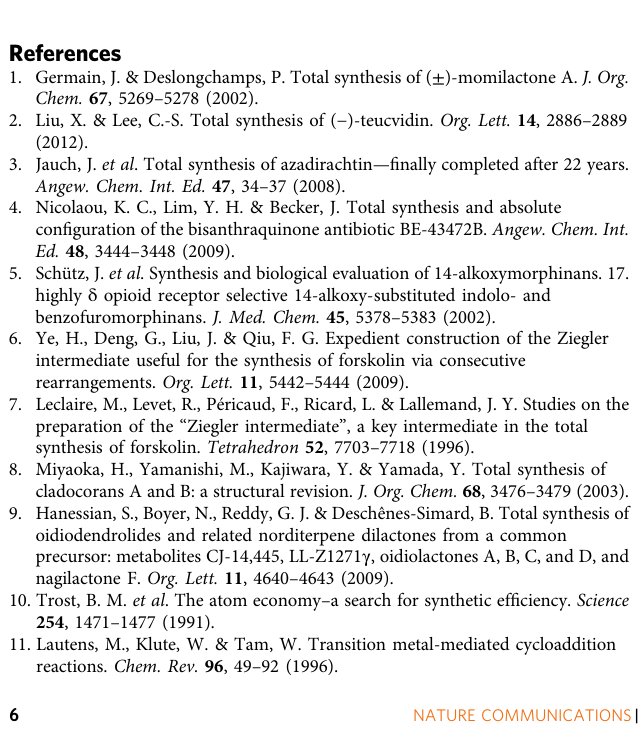
Data availability . The X-ray crystallographic coordinates for structures reported in this study have been deposited at the Cambridge Crystallographic Data Centre (CCDC) under deposition numbers CCDC 1523827 ( 3ik ) and 1523828 ( 8 ). These data can be obtained free of charge from The CCDC via www.ccdc.cam.ac.uk/ data_request/cif. All other data supporting the fi ndings of this study are available within the article and its Supplementary Information fi le or from the authors upon reasonable request. For NMR spectra of the compounds in this article, see Supplementary Figs. 2 – 31.